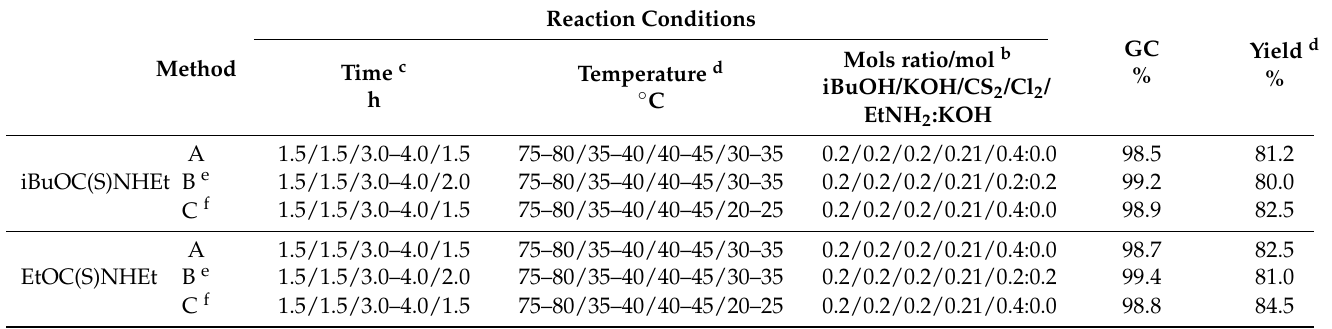
Table 1. Optimization of synthesis of N -ethyl- O -isobutyl and N -ethyl- O -ethyl